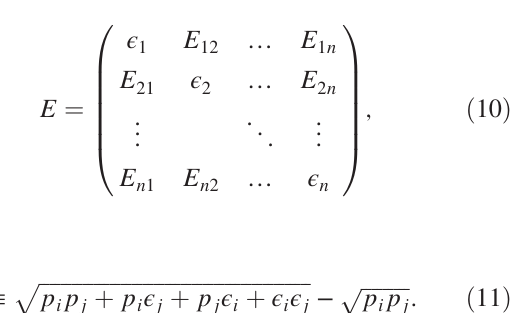
FIG. 1. Depiction of the various regions of the model plot and the information that can be ascertained therein for a set of questions that provide responses that can be classified as either correct (model 1) or corresponding to a single incorrect mental model (model 2). This figure was recreated from Ref. [2], where σ 2 μ th eigenvalue of the class model density matrix and v μ is the is the i th component of the μ th